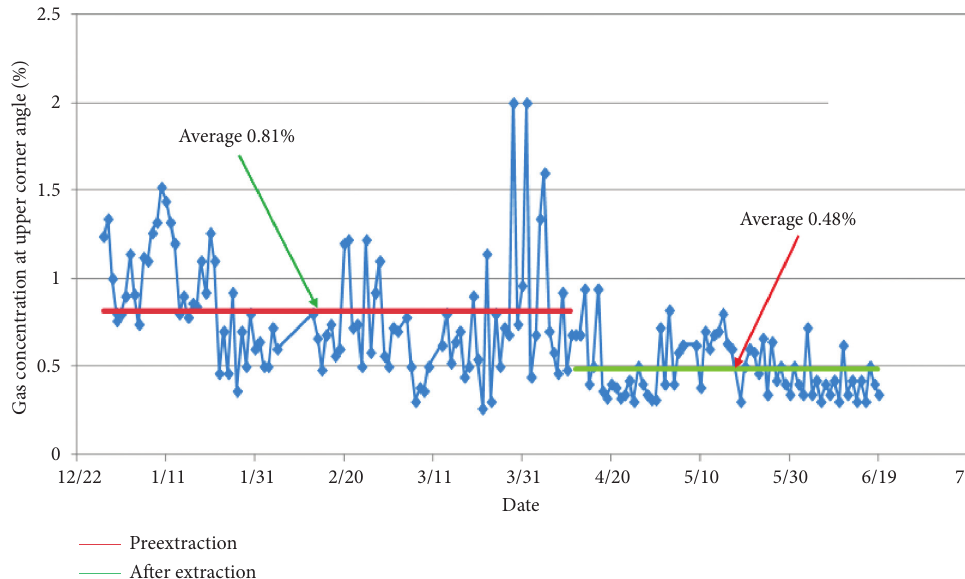
Figure 9: Upper-corner gas concentration tracking